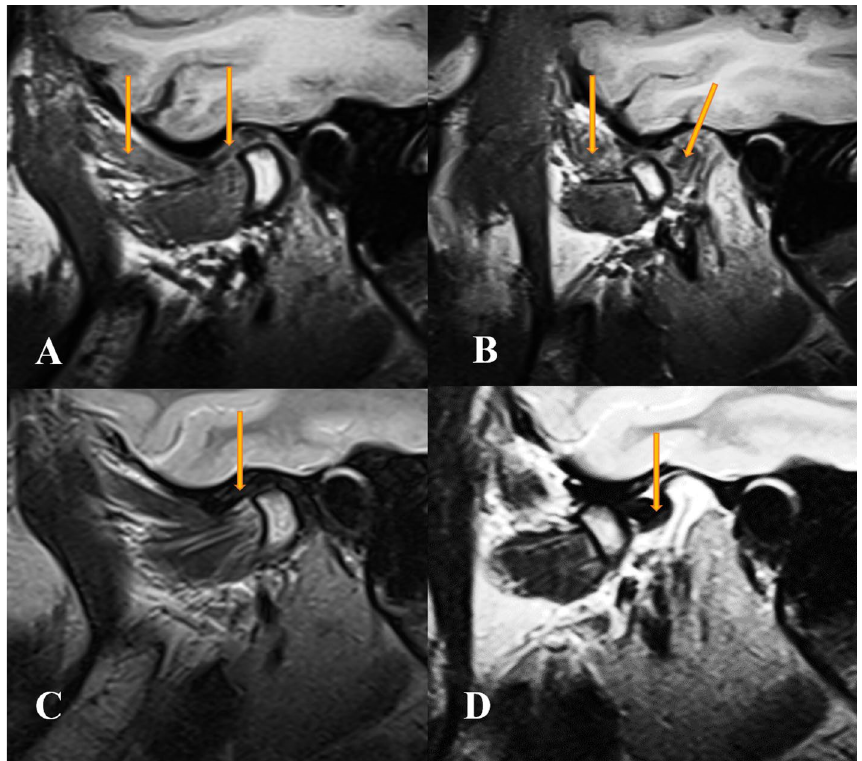
Figure 4. Oblique sagittal T1-weighted images showed normal Condyle -disk -Fossa relationship associated with fatty degeneration of the SLPM and degeneration of the disk in close ( A ) & mouth position with posterior disk displacement of the disk in open ( B ) mouth position (the arrow). Oblique sagittal T2-weighted images showed normal Condyle -disk -Fossa relationship in close ( C ) mouth position with posterior disk displacement of the disk in open ( D ) mouth position (the